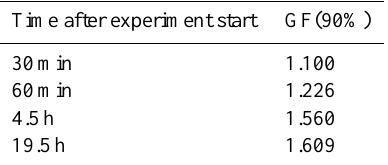
Table 6. Growth factors at 90% RH, experiment Humid